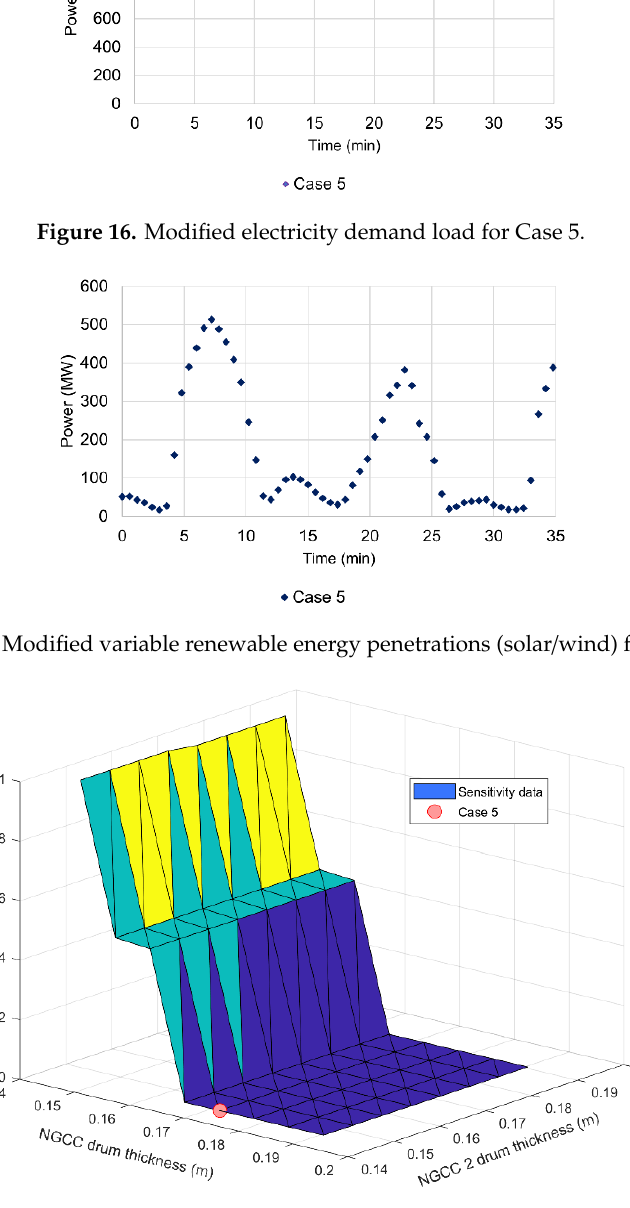
Figure 18. Sensitivity analysis of optimization objective due to NGCC and NGCC 2 drums’ thicknesses.